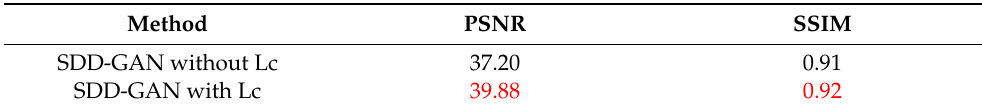
Table 8. Average PSNR and SSIM (with L C vs. without L C ) on the RSDATA dataset. The highest scores are highlighted in